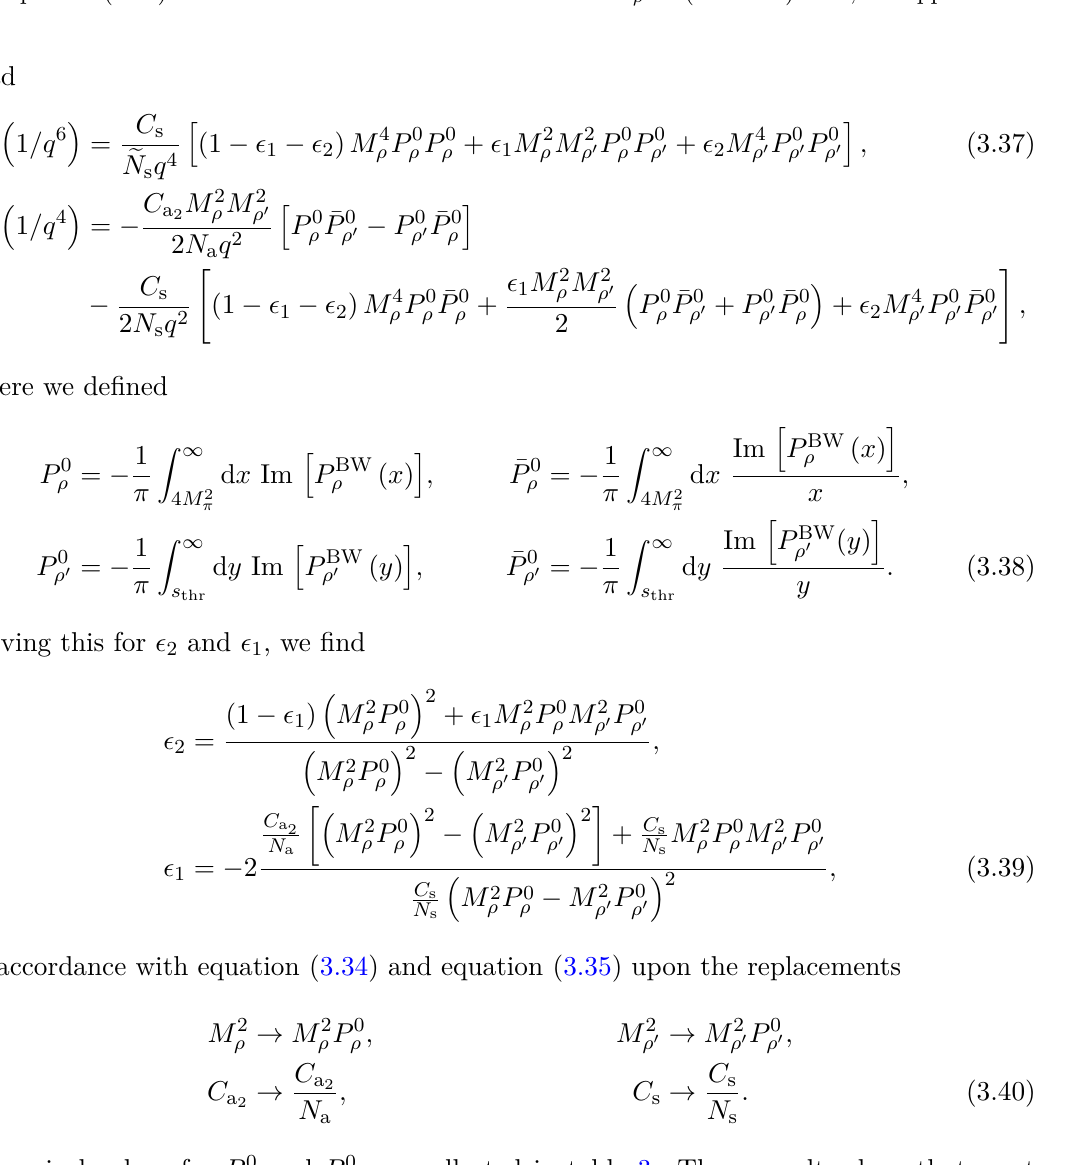
Table 3 . Numerical values of P 0 and P 0 , equation (3.38), as obtained with the parameterizations ρ ρ 0 Γ (2) ρ ( q 2 ) , Γ (4 π ) ( q 2 ) , and Γ ( ωπ,ππ ) ρ 0 ρ